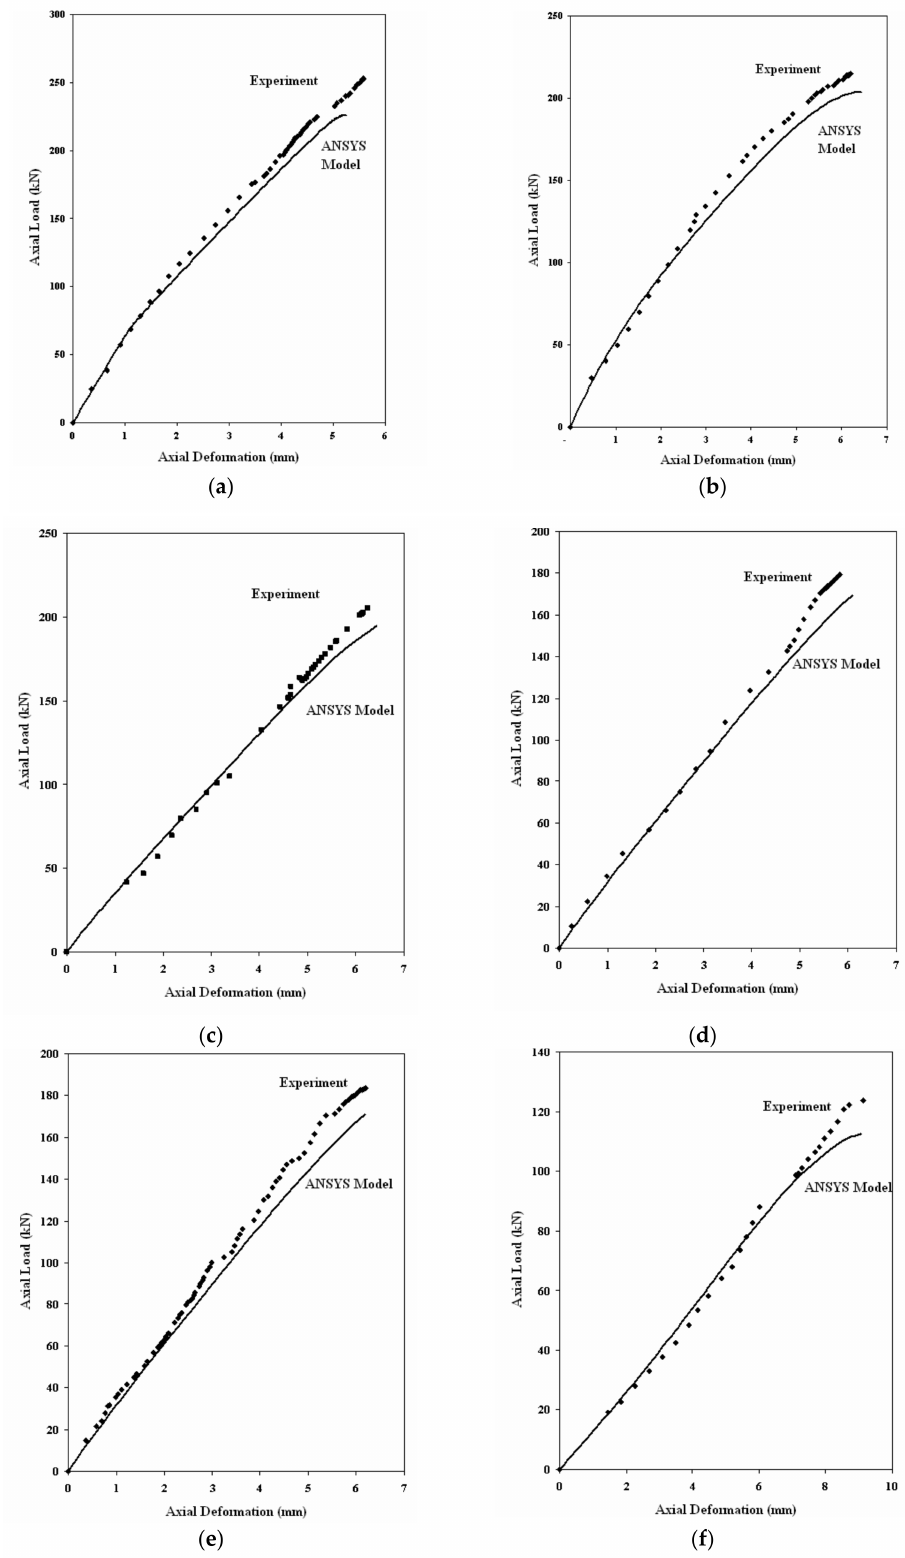
Figure 21. Axial load vs. deformation curve for GFRP-stiffened composite plates. ( a ) LSTP1 ( b ) LSTPO1 ( c ) LSTP2 ( d )LSTPO2 ( e ) LSTP3 ( f )